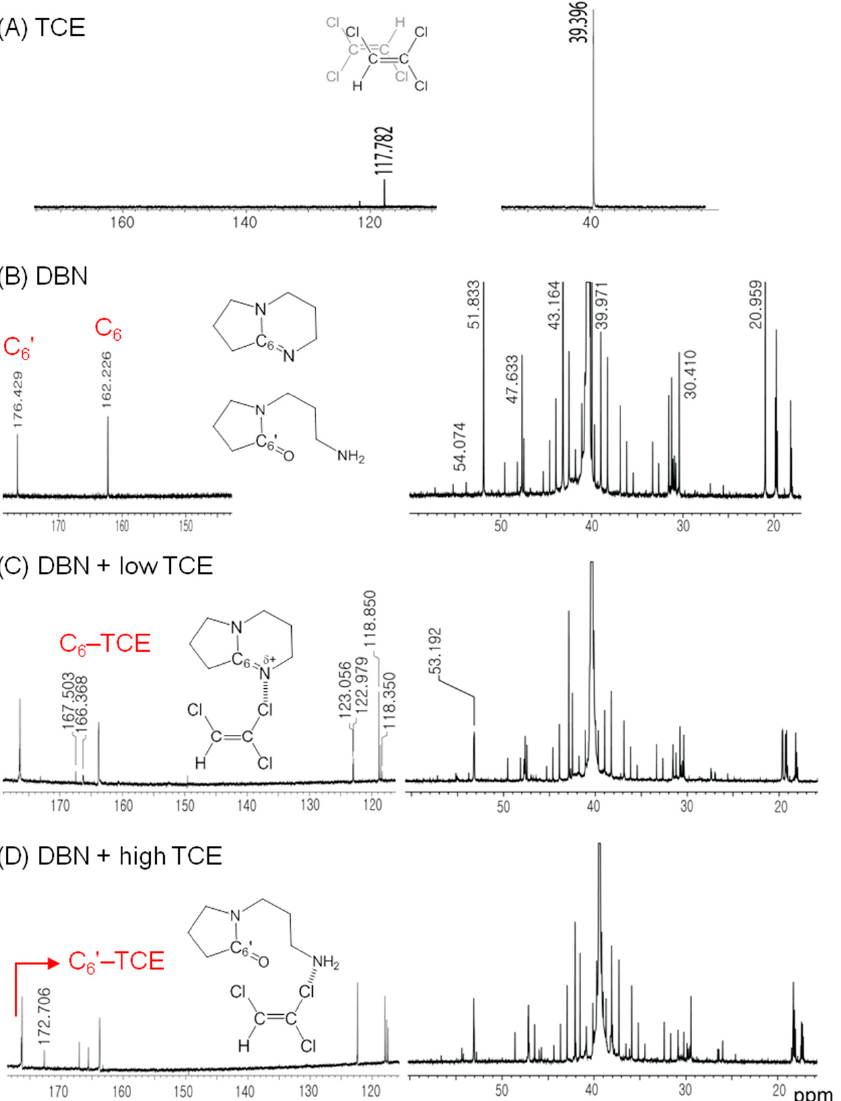
Figure 1. 13 C-NMR spectra of TCE, DBN, and their mixture. ( A ) TCE in DMSO/D 2 O. One major chemical shift at 117 ppm and the other minor shift at 122 ppm. ( B ) DBN in DMSO/D 2 O. 162 ppm: C 6 carbon of DBN, 176 ppm: C 6 ′ carbon of the hydrolyzed DBN. ( C ) The mixture of DBN and a low concentration of TCE. TCE interacts with DBN by Cl···N halogen bonding. C 6 -TCE: downfield shift of C 6 carbon of DBN by the interaction with TCE. ( D ) The mixture of DBN and a high concentration of TCE. The amine group of the hydrolyzed DBN interacts with TCE, and the downfield shift of C 6 ′ carbon is insignificant (labeled C 6 ′ -TCE). The peak intensity of TCE increases with the increase in TCE concentration. The (broad) peak around 39 ppm is DMSO.